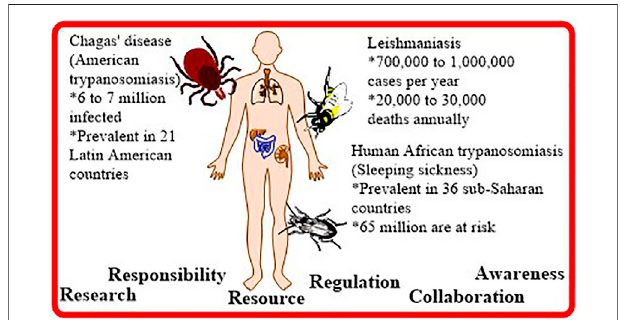
FIGURE 1 | Global scenario of three neglected tropical diseases: Chagasdisease(American trypanosomiasis),HumanAfricantrypanosomiasis (HAT), and